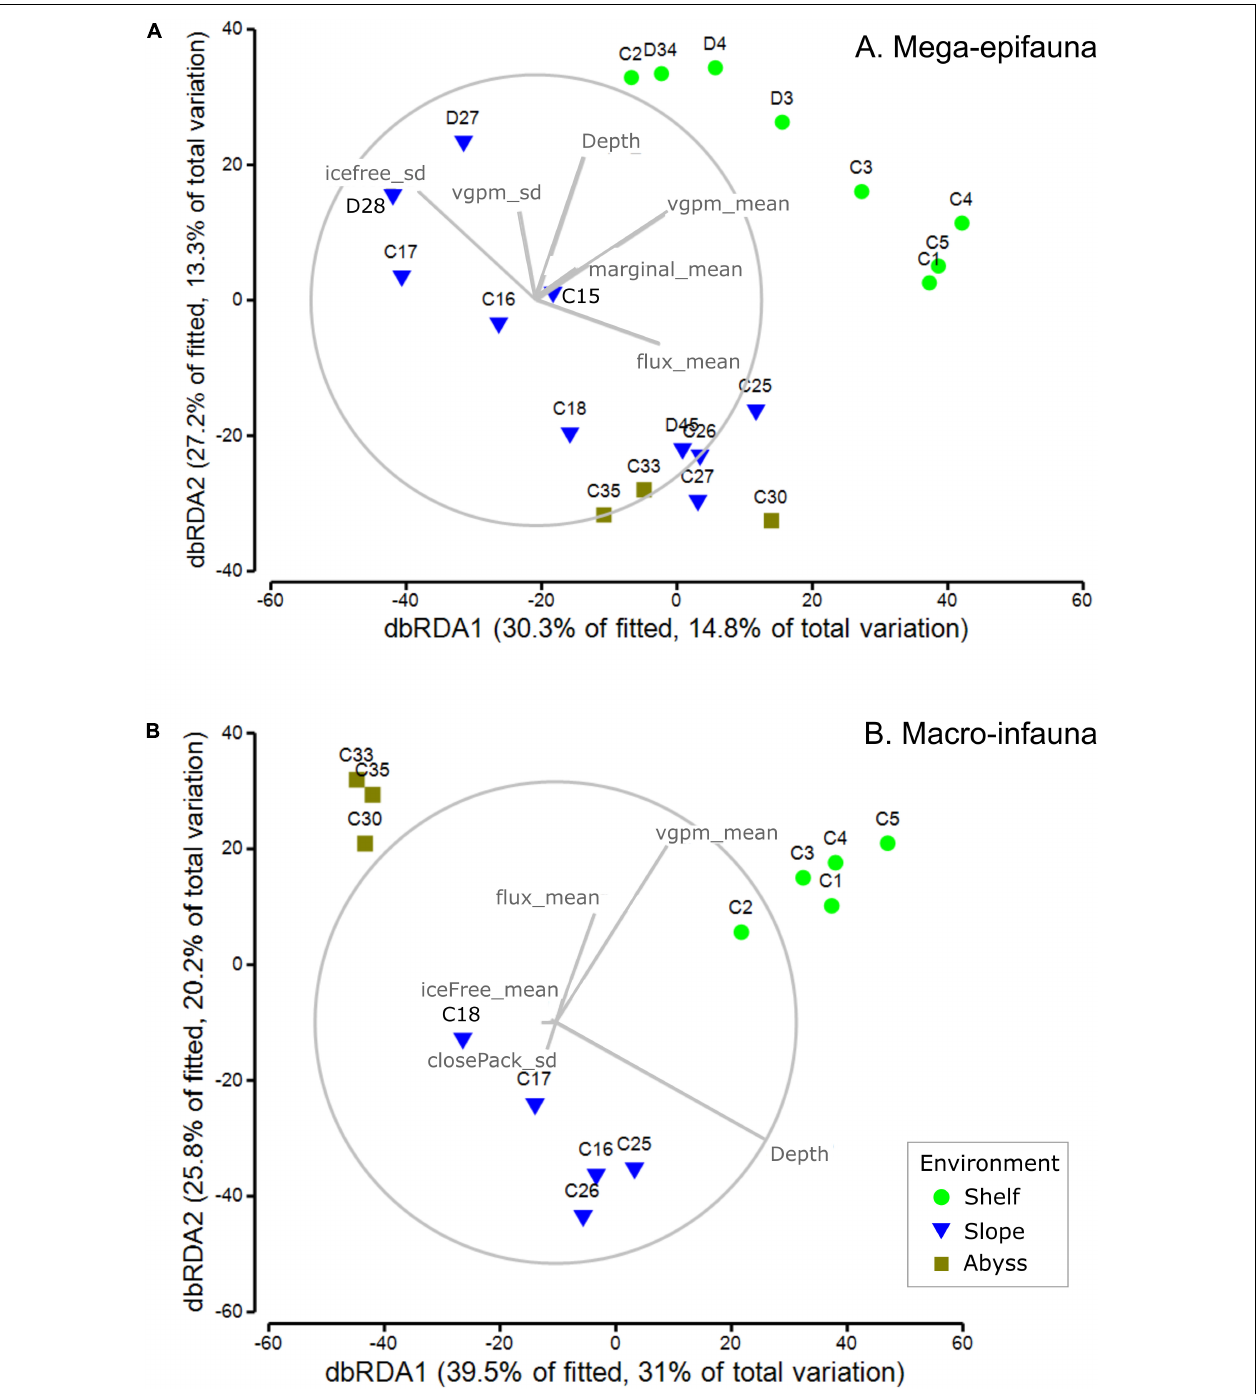
FIGURE 7 | dbRDA ordinations community composition of (A) mega-epifaunal and (B) macro-infaunal at each site. Vector overlays indicate the strength and direction of the relationships between sea ice- and productivity-associated environmental variables on the dispersion of samples in the ordination. DistLM outputs are provided in Supplementary Tables 2 , 3 ,